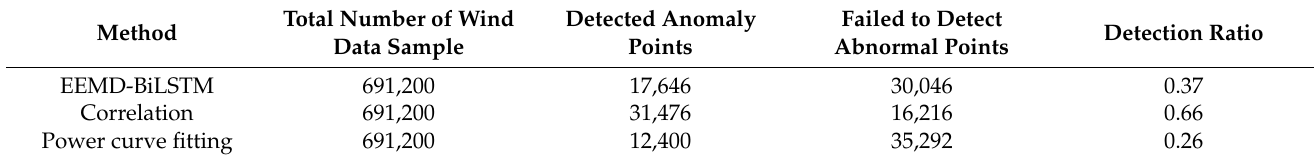
Table 10. Detection of abnormal situations from SCADA